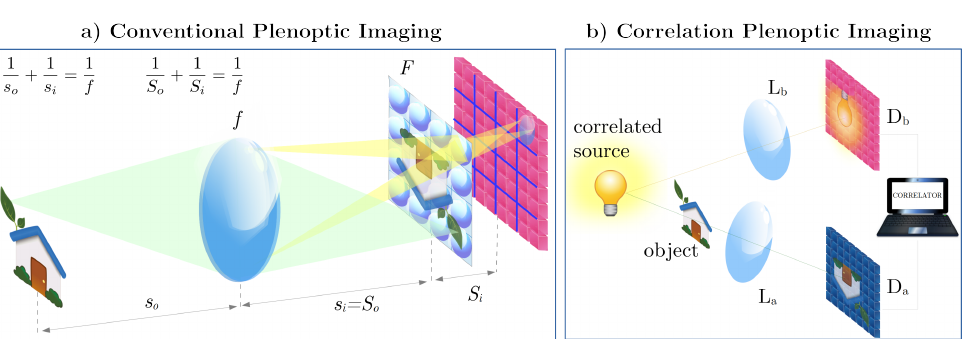
Figure 1. ( a ) the scheme of a conventional plenoptic imaging (PI) device: the image of the object is focused on a microlens array, while each microlens focuses an image of the main lens on the pixels behind. Such a configuration entails a loss of spatial resolution proportional to the gain in directional resolution; ( b ) shows the scheme of a correlation plenoptic imaging (CPI) setup, in which directional information is obtained by correlating the signals retrieved by a sensor on which the object is focused with a sensor that collects the image of the light source. The image in ( a ) is reproduced with the permission from Ref. [16], copyright American Physical Society,